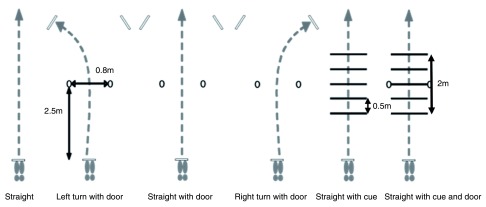
Walking conditions.